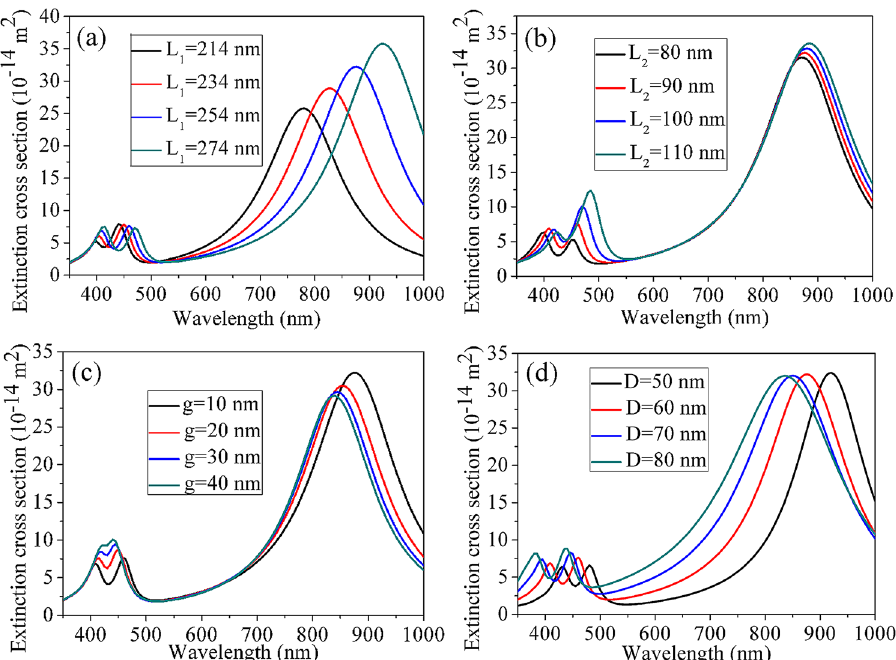
Figure 3. Extinction cross-sections of the trimers with different configuration parameters. ( a ) Varying the length of a long nanorice ( L 1 ) with fixed g = 10 nm, L 2 = 90 nm, D = 60 nm. ( b ) Varying the length of a short nanorice pair ( L 2 ) with fixed g = 10 nm, L 1 = 254 nm, D = 60 nm. ( c ) Varying the gap ( g ) with fixed L 1 = 254 nm, L 2 = 90 nm. ( d ) Varying the diameter of the nanorice trimer ( D ) with fixed g = 10 nm, L 1 = 254 nm, L 2 = 90